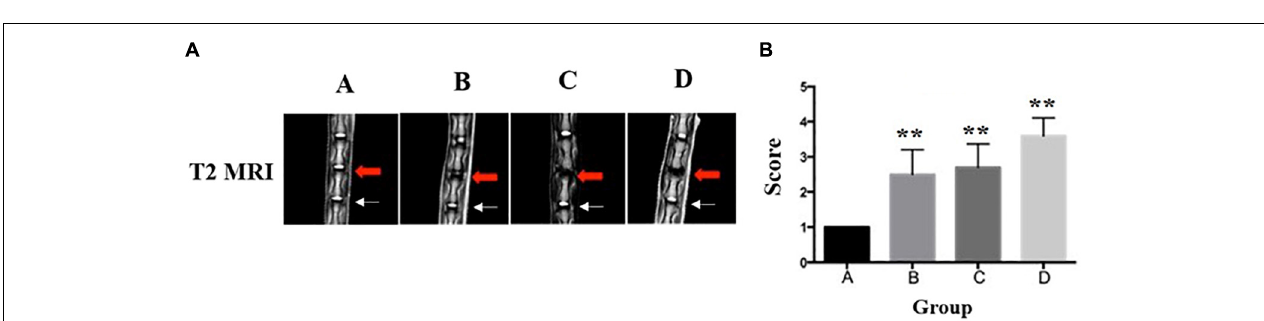
FIGURE 3 | (A) Progressive increase of average bone density. One-way ANOVA multiple comparison showed that there was no difference between group A and group B. In both group C and group D, there were significant differences with group A ( p < 0.001). (B) The heat map of representative radiographs visualized the progression of vertebral osteogenesis in punctured disc disk (red arrow) over time. ****, significant difference from other groups ( p ≤ 0.0001)